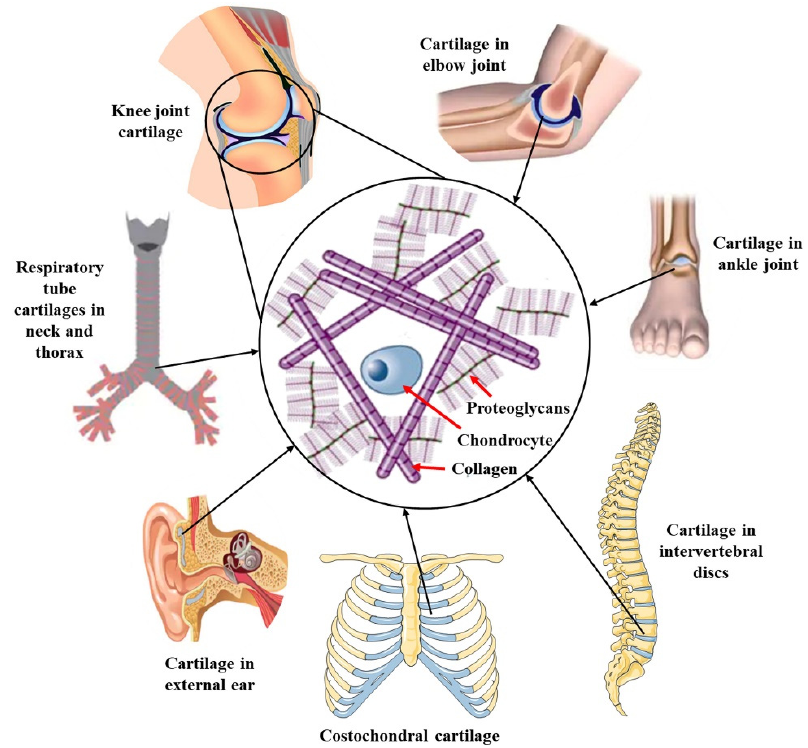
Figure 13. Diagram of cartilage tissue and its structure in different parts of the human body. Colla- gen (type II), proteoglycans and chondrocytes are the major components of cartilage tissue. Data reproduced from ref. [129].